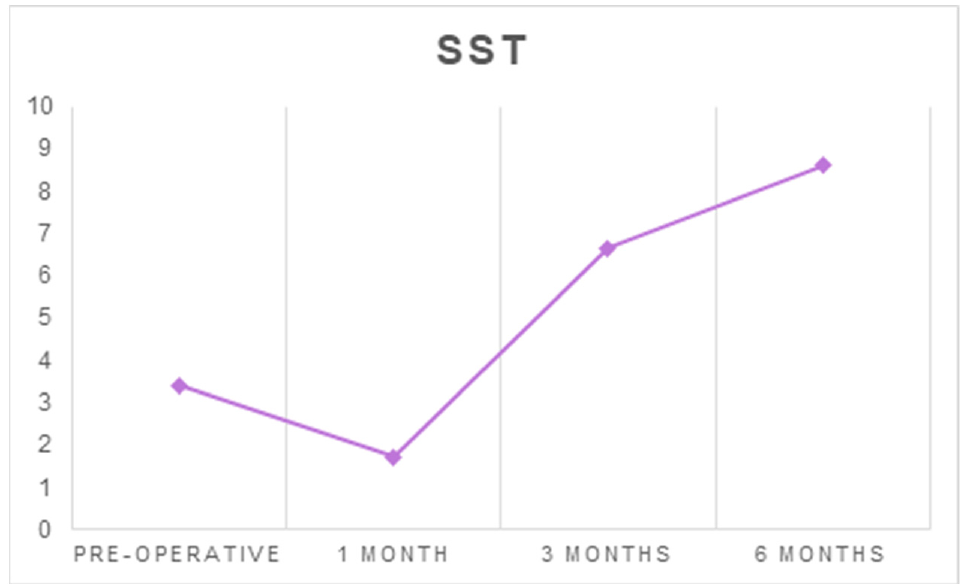
Figure 3. The average scores of SST at each follow-up timepoint. The mean ASES increased from 43.94 ± 20.4 before surgery to 84.95 ± 13.27 at six months after surgery ( p < 0.001) (Tables 1 and 2, Figure 4).